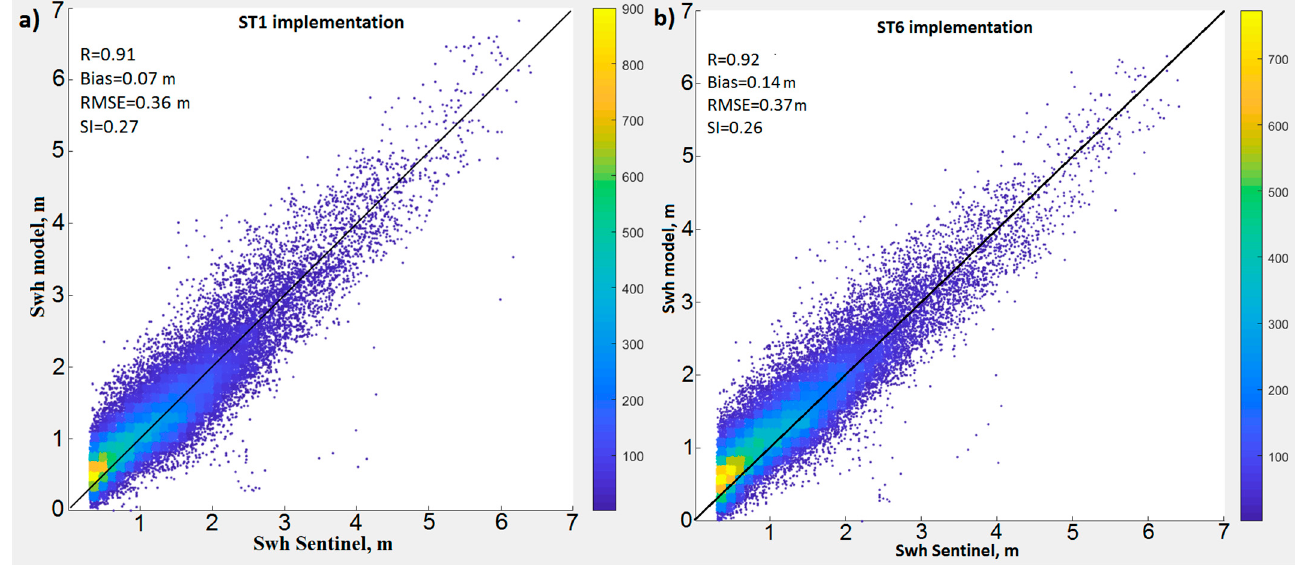
Figure 4. Scatter diagram of simulated SWH and Sentinel data for two model implementation: ( a ) ST1, ( b ) ST6.